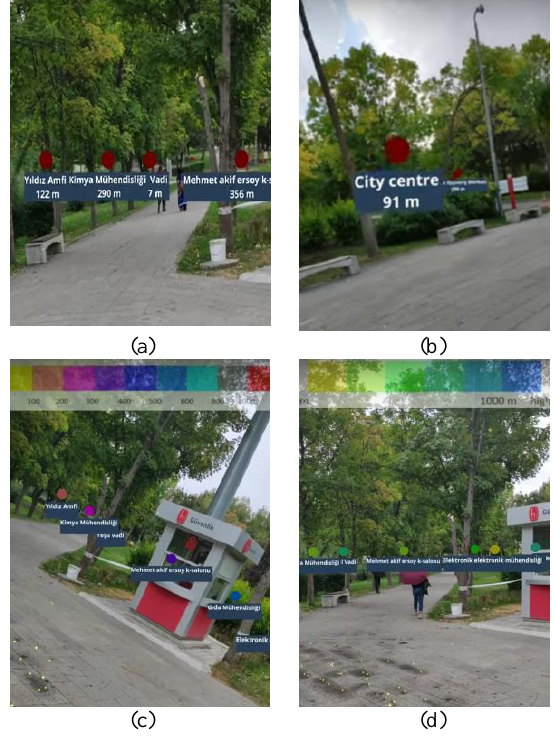
Figure 3. POI visualisation based on the distance: same size and colour (a), same colour different size (b), discrete colour (c), gradient colour (d) The default setting to visualise POIs in Mapbox is the ‘same colour different size’ option, where the size of the POIs get smaller with the distance from the user. Specifically, Figure 3b is closest to the default way of visualising POIs in Mapbox. In order to assure that all of the POIs are visualised in same size, the more distant POIs to the user must be displayed larger. In order to achieve this, equation 1 was used to adjust the point size depending on the Figure 2. Two students and a participant performing the direction task (a) and an exemplar screenshot from the mobile device (b)